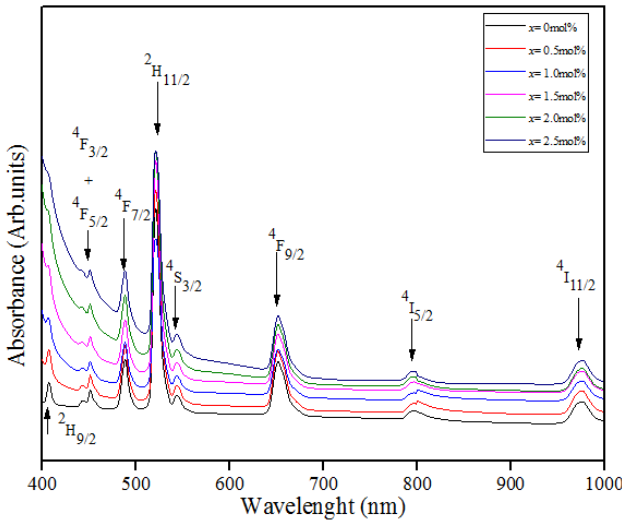
Figure 5. UV–Vis–NIR absorption spectra of (59.5– x ) B 2 O 3 –20Na 2 O–20CaO– x V 2 O 5 –Er 2 O 3 –0.5AgCl ( x = 0, 0.5, 1.0, 1.5, 2.0 and 2.5